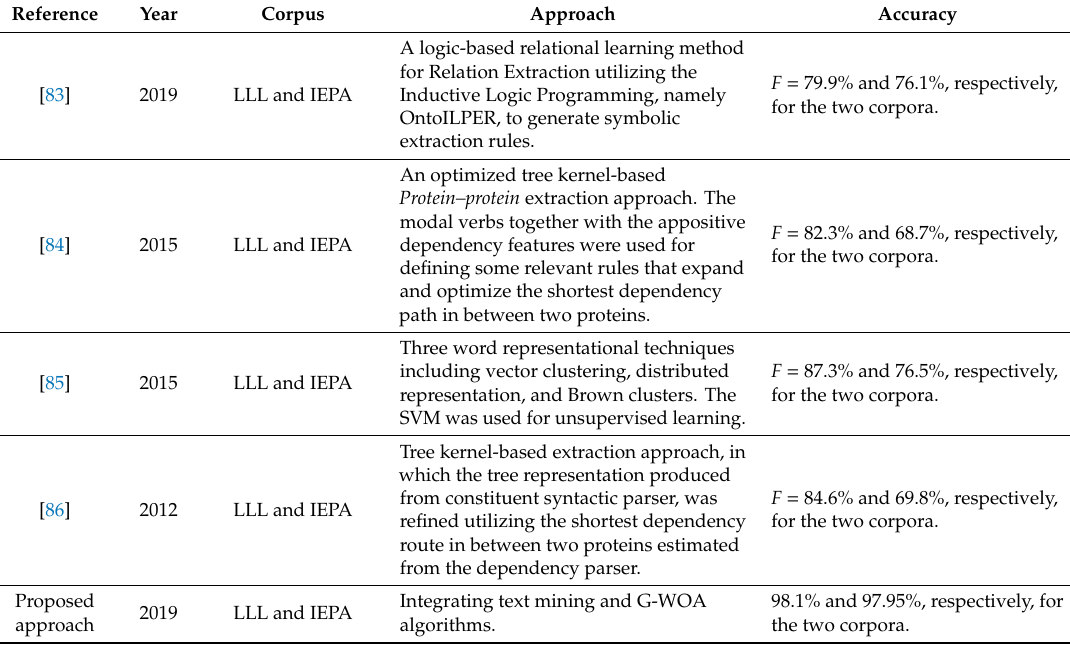
Table 7. Comparison to the state-of-the-art in non-Arabic